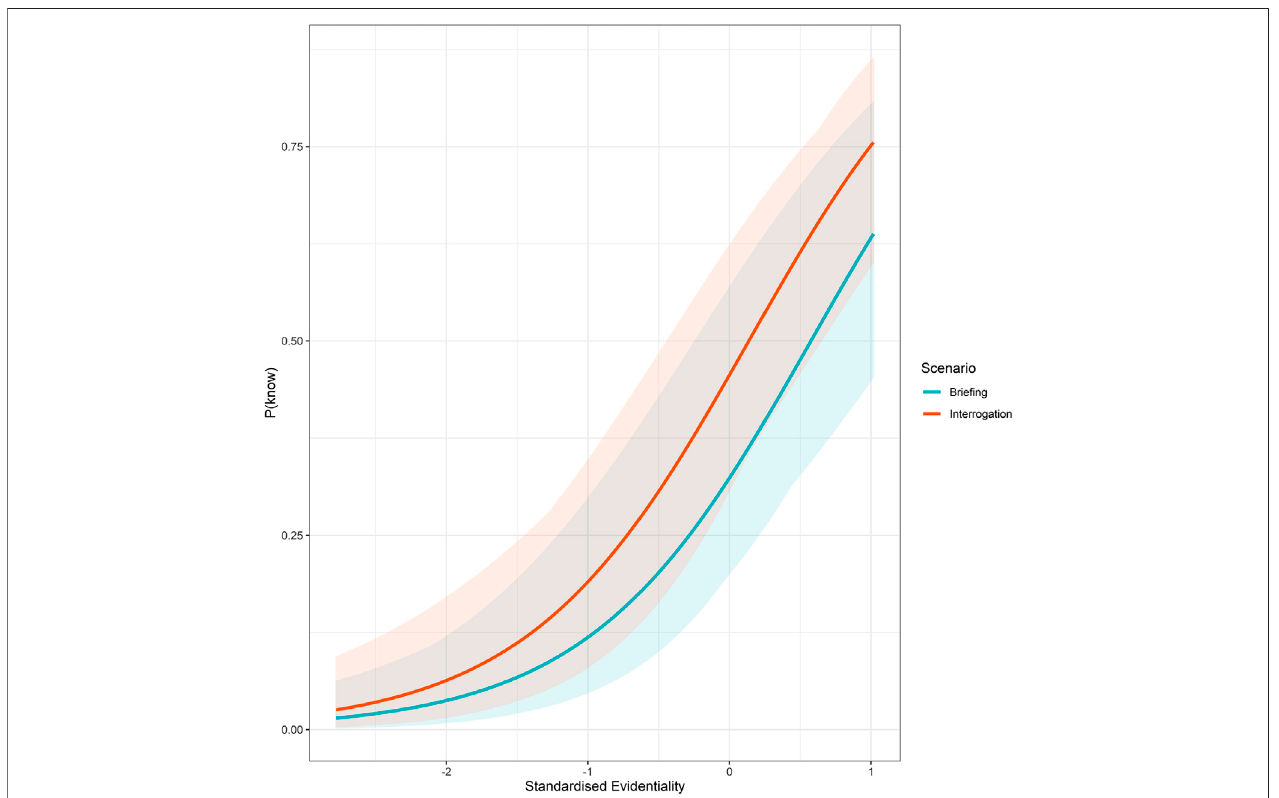
FIGURE3| Predictionsofourmodelgivenourdata.Log-oddswereback-transformedtoprobabilities( y -axis).The x -axisisthestandardisedevidentialitymeasure: 0standsforanevidentialityof73.Anincreaseofonestandarddeviationonthestandardisedscalemeansanincreaseof26ontheoriginalscale.Thelinesrepresentsthe means of the fi xed effects and the faded area depicts the 95% credible interval of the fi xed effects.